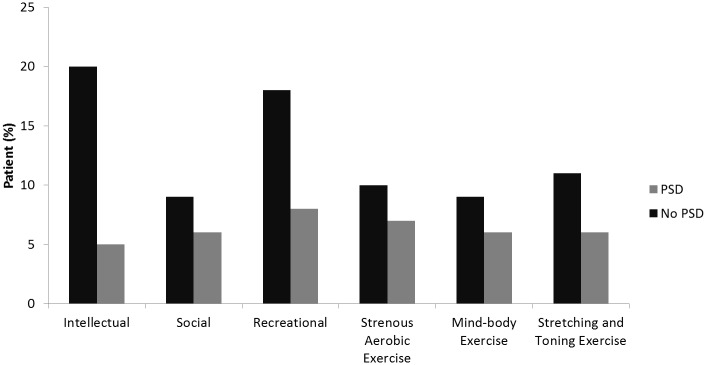
Comparison of regular participation in various activity categories in patients with and without PSD.*p<0.05 / **p<0.01 for group difference.